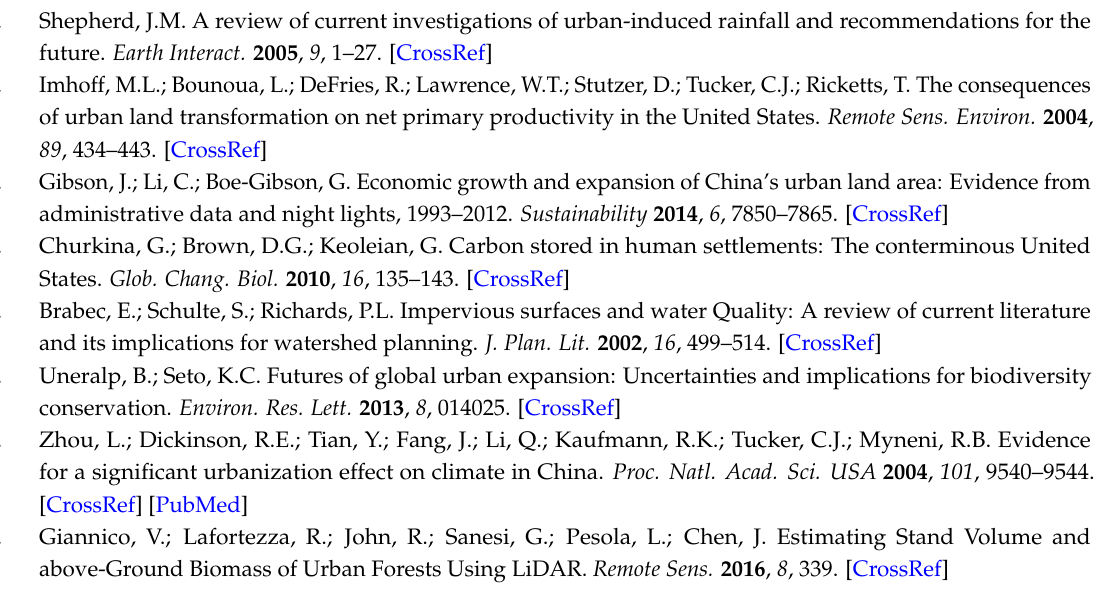
Table S1: Landsat dataset (Path 32, Row 27) used in this study, Table S2: DMSP/OLS data used in this study and their inter-annual calibration